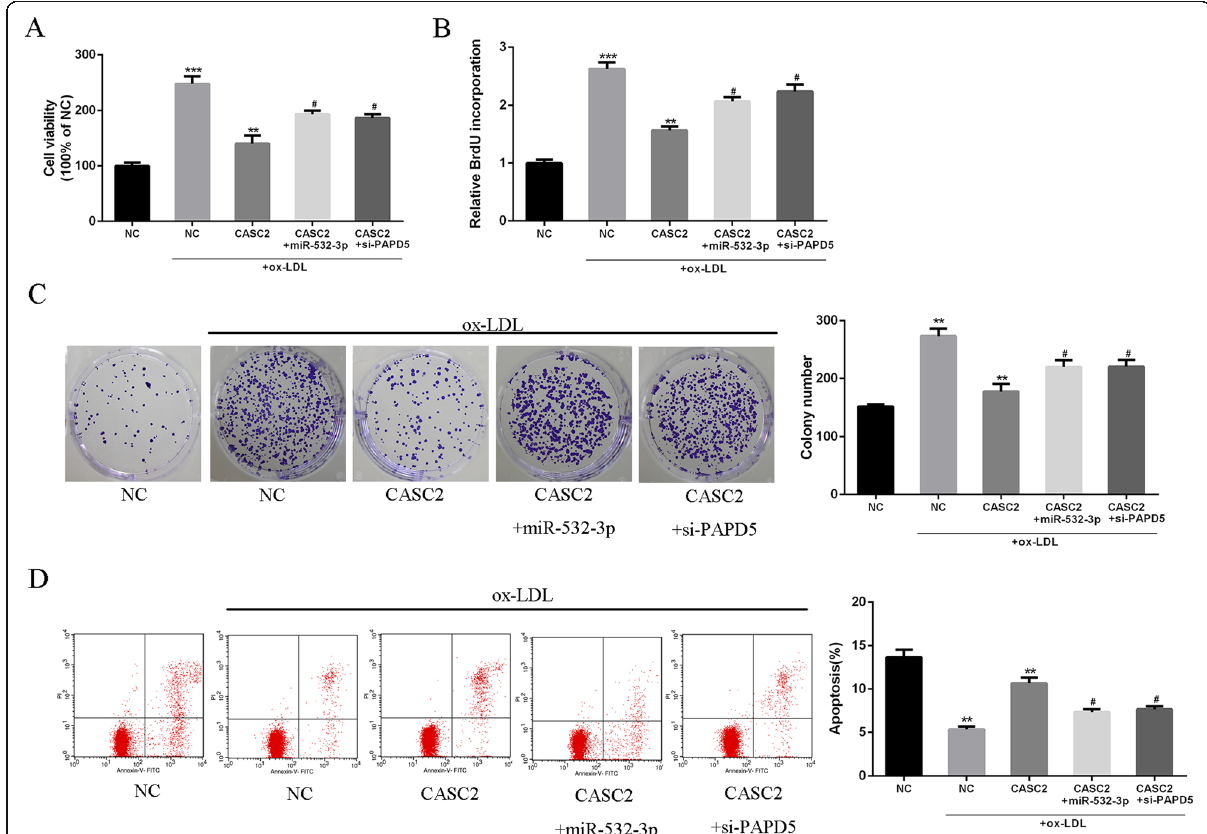
Fig. 4 Over-expression of miR-532-3p or silencing of PAPD5 on the lncCASC2-induced proliferation of VSMCs. a CCK-8 assay of VSMCs co- transfected with CASC2 or control, and miR-532-3p mimic or si-PAPD5. b BrdU incorporation assay of VSMCs co-transfected with CASC2 or control, and miR-532-3p mimic or si-PAPD5. c Colony formation assay of VSMCs co-transfected with CASC2 or control, and miR-532-3p mimic or si-PAPD5. d Cell apoptosis assay of VSMCs co-transfected with CASC2 or control, and miR-532-3p mimic or si-PAPD5. * vs. NC group or NC + ox- LDL group, # vs. CASC2 group. *** P < 0.001, ** P < 0.01, # P <